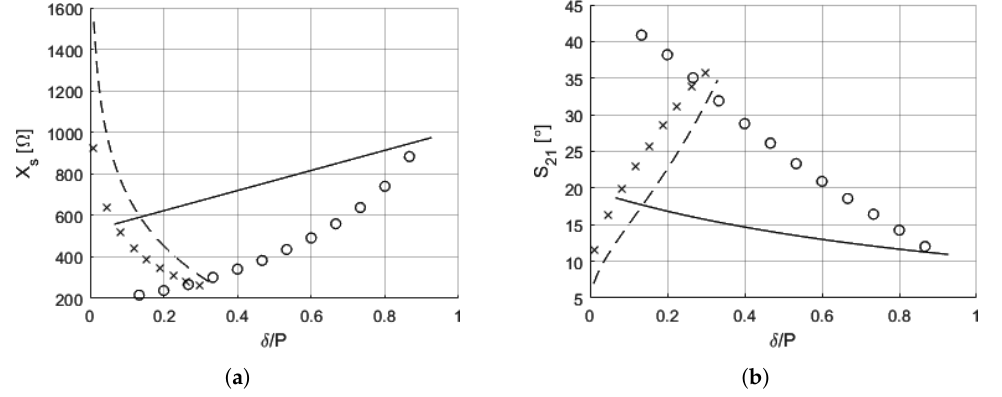
Figure 9. Performance of meander line unit cells. P ⊥ = P (cid:107) = P . Lines are analysis, points simulation results. Solid and circles— δ ∼ h , w (cid:107) = w ⊥ = P ⊥ /15; dashed and crosses— δ ∼ w (cid:107) = w ⊥ , h = 2 P ⊥ /3. ( a ) Surface reactance; ( b ) phase